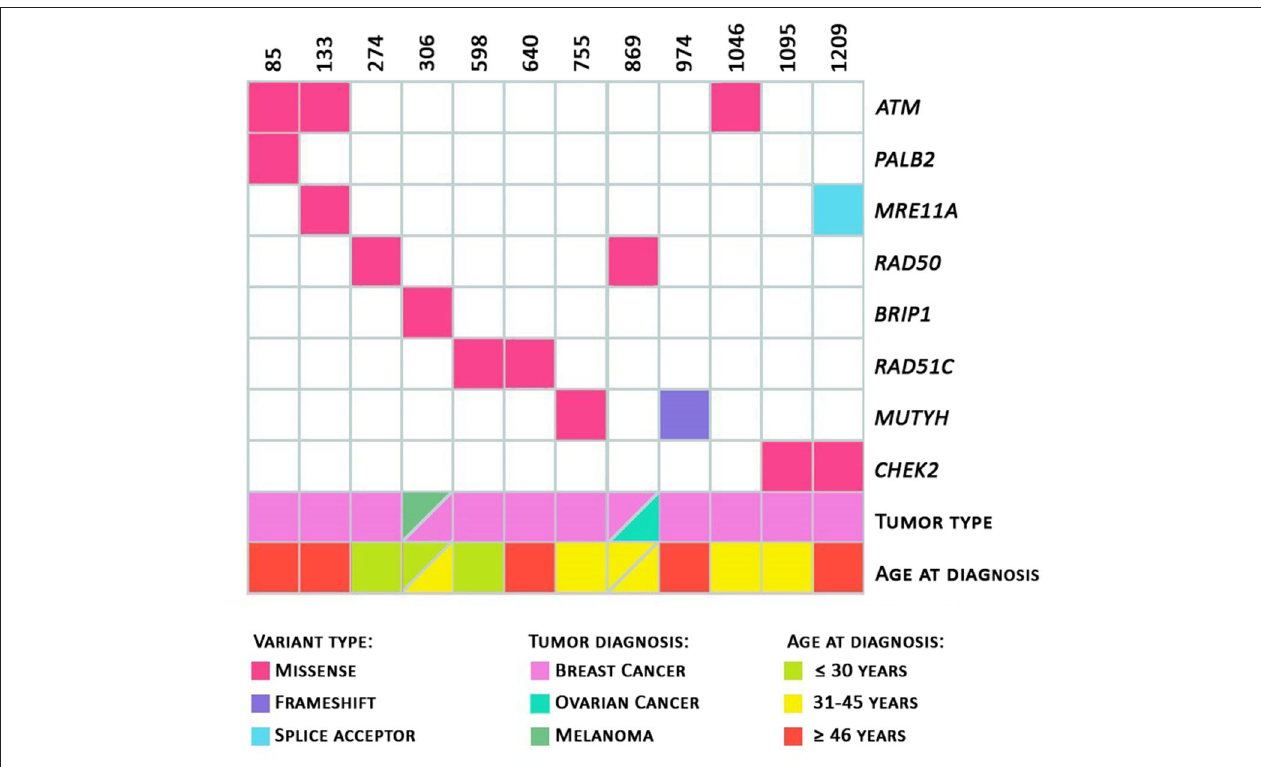
FIGURE 2 | Heatmap. Total number of variants per patient. Variants identified with information regarding the tumor diagnosed and the patient’s age at diagnosis; and age at diagnosis (in green: diagnosis ≤ 30 years of age; in yellow: 31 to 45 years of age; in red: ≥ 46 years of age) are